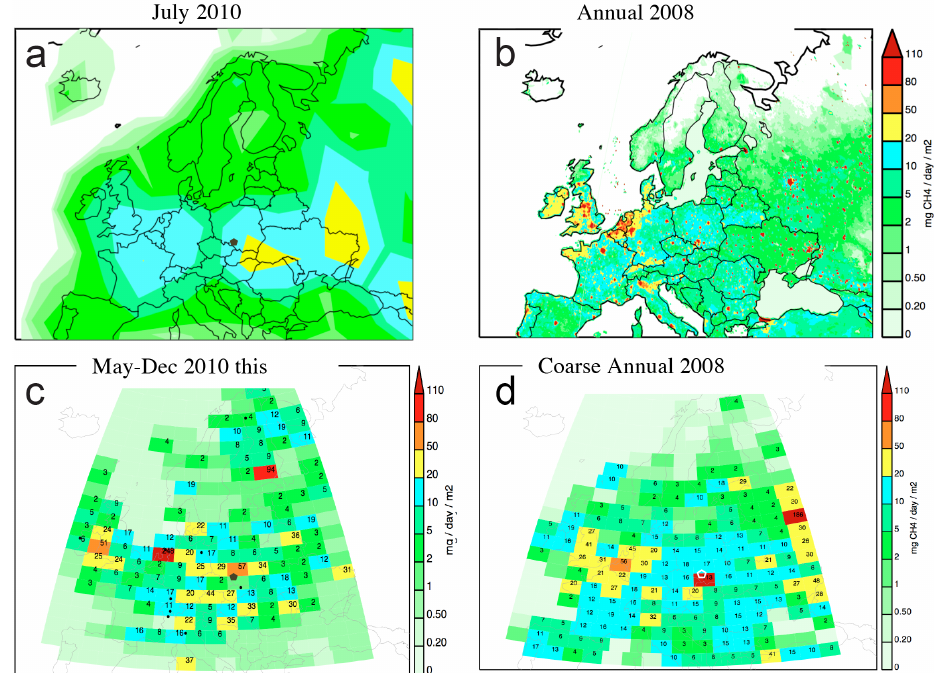
Fig. 6. (a) Monthly retrieved emission strengths from the European Monitoring Atmospheric Composition and Climate (MACC) collaborative project for July 2010. (b) Annual anthropogenic surface emissions from the Emission Database for Global Atmospheric Research (EDGAR) for 2008. (c) Average retrieved emission strengths from this study May–Dec 2010. (d) EDGAR 2008 integrated over our 262 surface tiles. (a) , (c) and (d) show the upper Silesia mining district with dark pentagon. Each tile with significant emission has value shown in